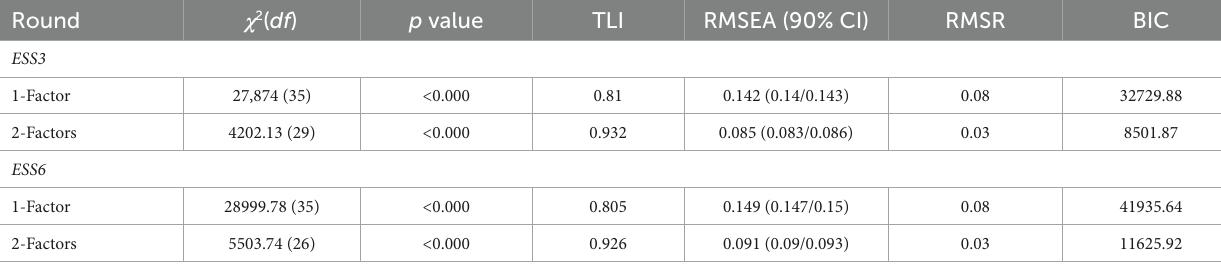
TABLE 2 Global fit indices for measurement models with one, two or three factors in each ESS round ( N ~ 45,000) total number of observations was 54,673. Round χ 2 ( df